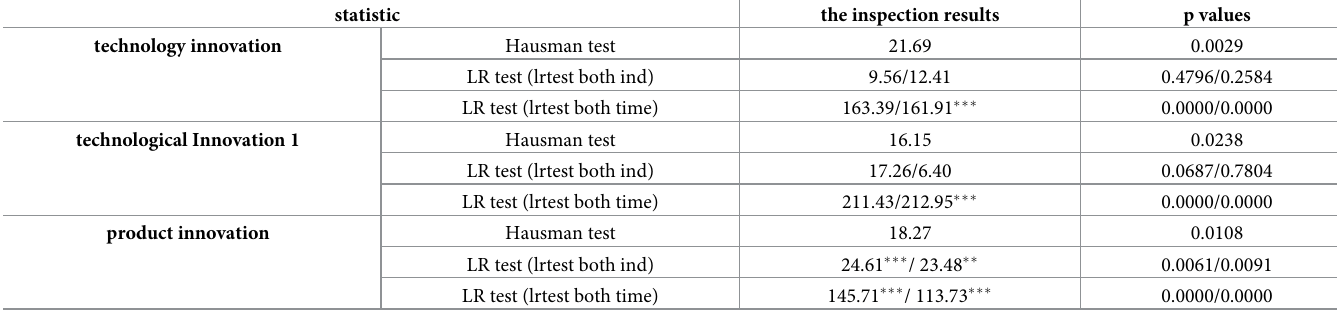
Table 4. Hausman test and LR test